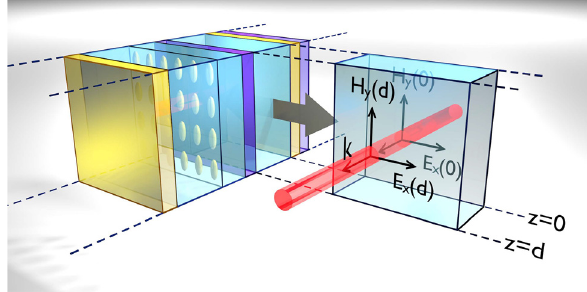
Figure 1: Schematic of an arbitrary 1D stack of materials, infinitely extending in x and y , including nonresonant metal and dielectric layers as well as resonant metasurfaces. Stack properties may be speci fi ed either by refractive index n and thickness d for normal material layers, or by metasurface re fl ection and transmission coef fi cients r a and t a . The highlighted slab shows right at its interfaces the electric and magnetic fi eld orientations and k -vectors of an incoming and outgoing wave (beam path indicated in red) at z = 0 and z = d , which are related via the transfer matrix in Eq.